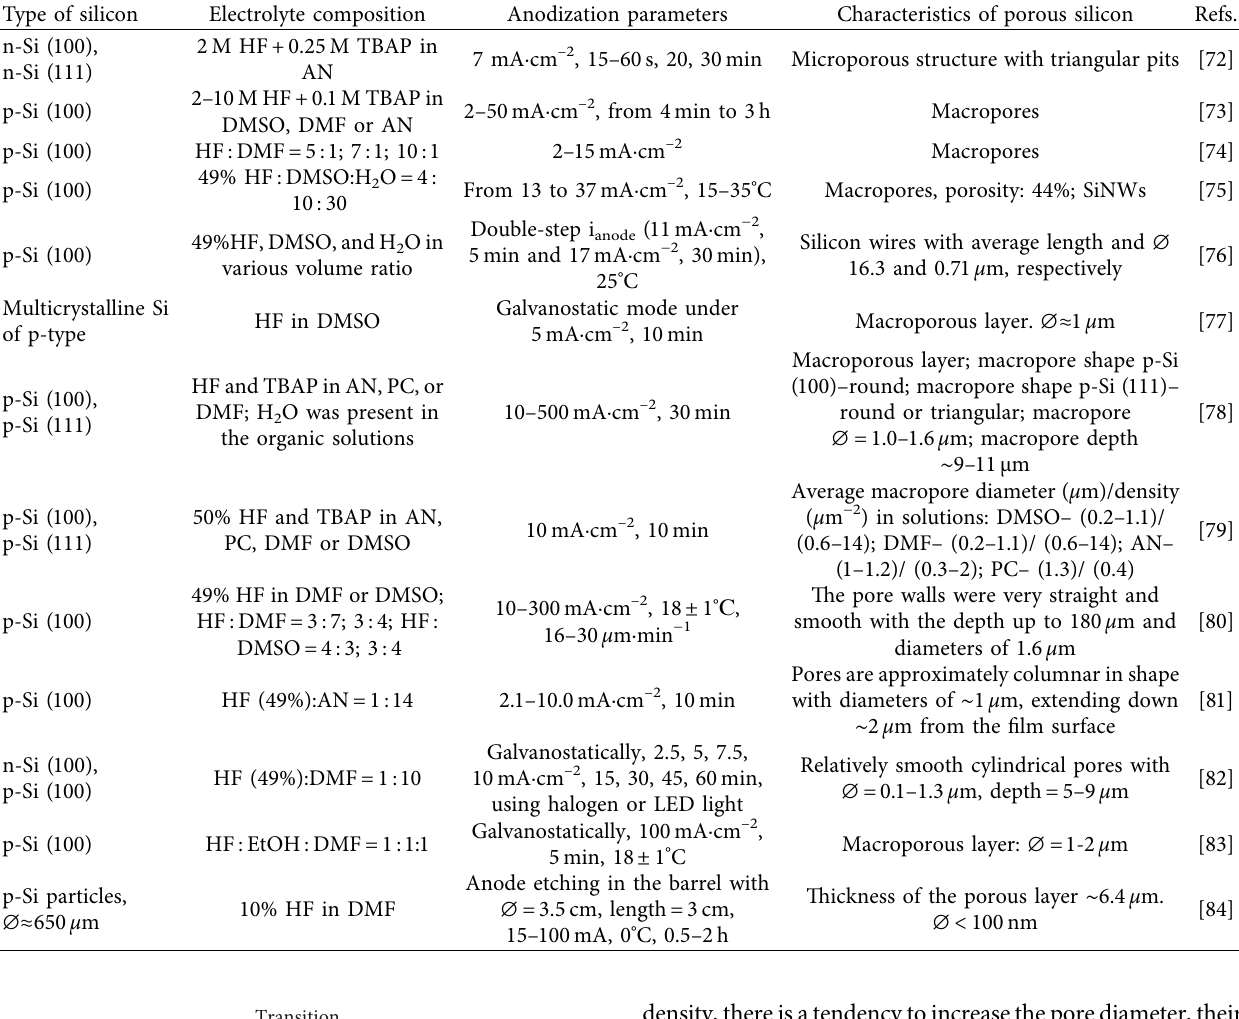
Table 2: S onditions for the formation of porous silicon by electrochemical etching in solution with organic aprotic solvents. Type of silicon Electrolyte composition Anodization parameters Characteristics of porous silicon Refs.